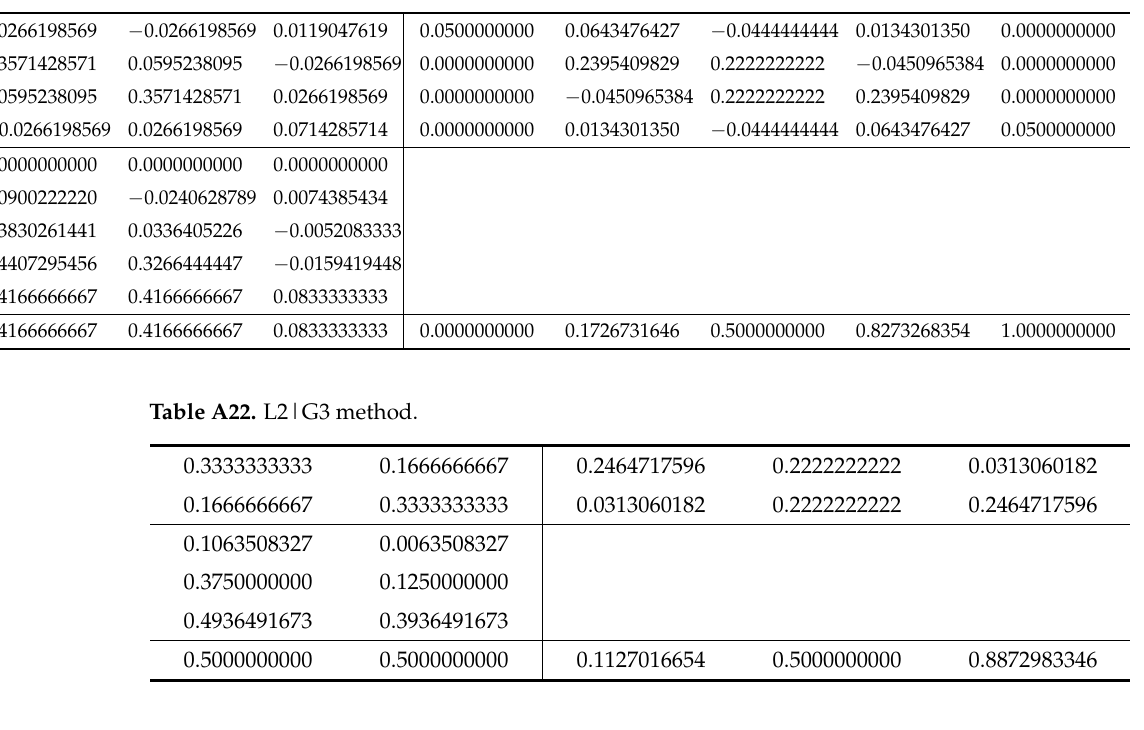
Table A21. L4|L5 method.